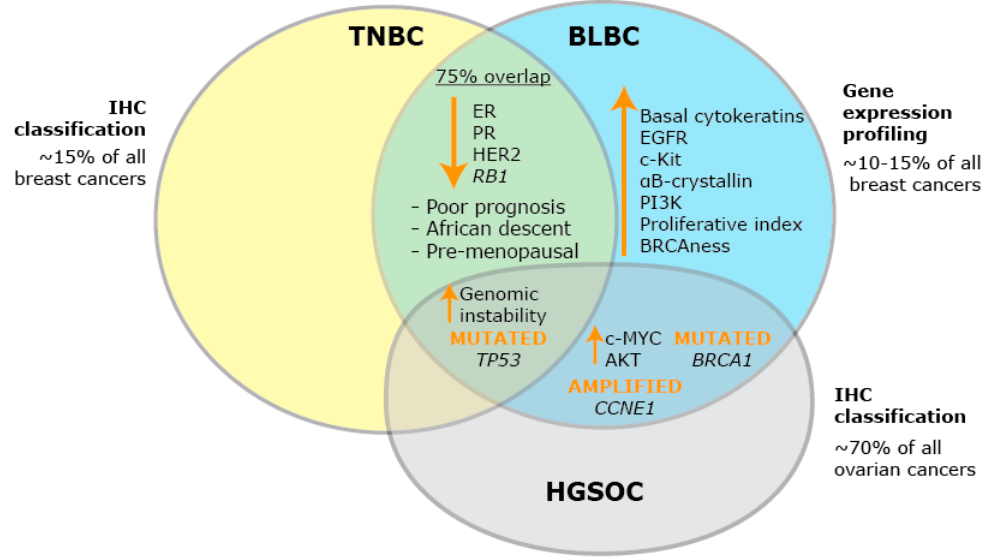
Figure 1. Defining BLBC. Schematic diagram of the defining features of triple-negative breast cancer (TNBC), basal-like breast cancer (BLBC) and high grade serous ovarian cancer (HGSOC). Orange upward arrows indicate an increase in expression; orange downward arrows indicate a decrease in